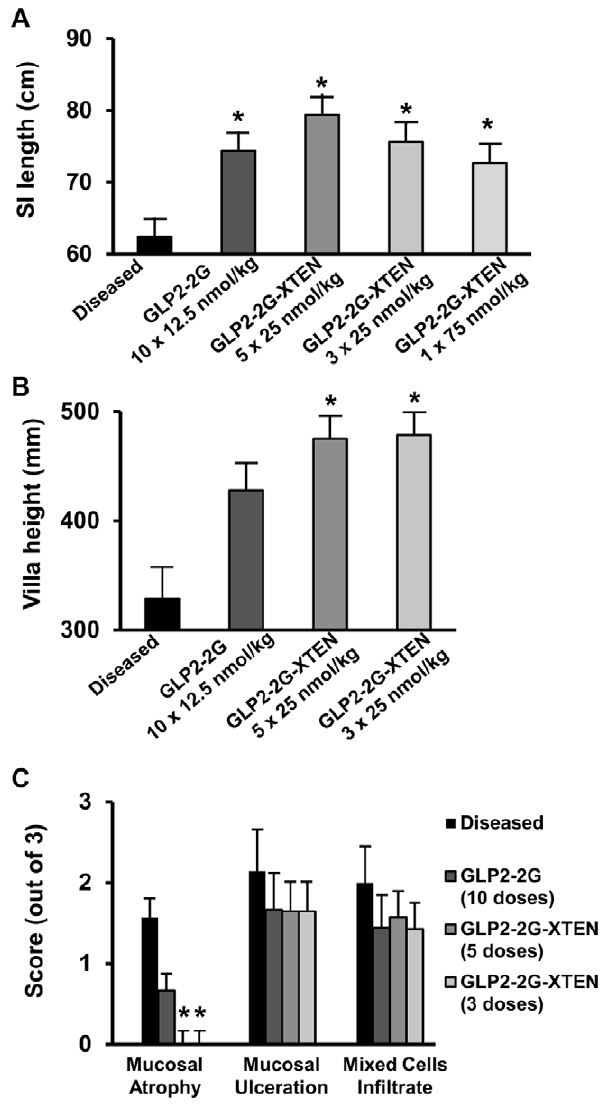
Figure 7. Treatment effects on small intestine length correlate with small intestine histopathology. A) Small intestine length B) villi height and C) mucosal atrophy, ulceration, infiltration measure- ments from diseased, vehicle-treated, GLP2-2G peptide-treated, and GLP2-2G-XTEN-treated rats. Quantitative histopathology was not performed on GLP2-2G-XTEN 75 nmol/kg single dose group.